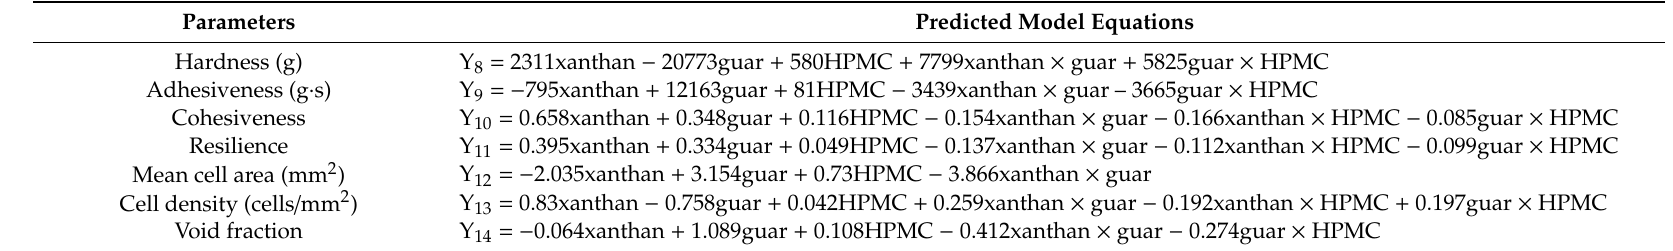
Table 6. Predicted polynomial models showing the e ff ect of each mixture component and their significant interactions on gluten-free bread crumb textural properties and crumb grain image analysis